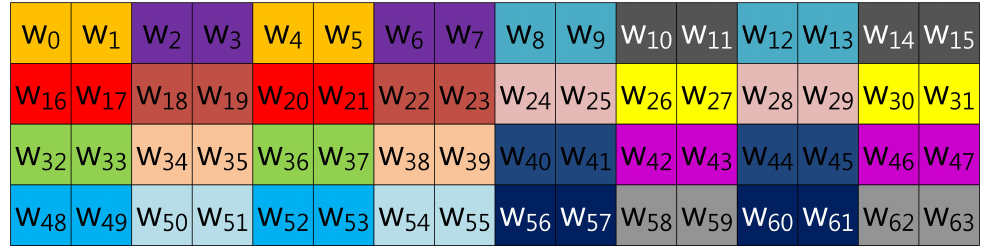
Figure 7. Look-up table structure of the (size-optimized) proposed method in block form for 4NAF (version 3).